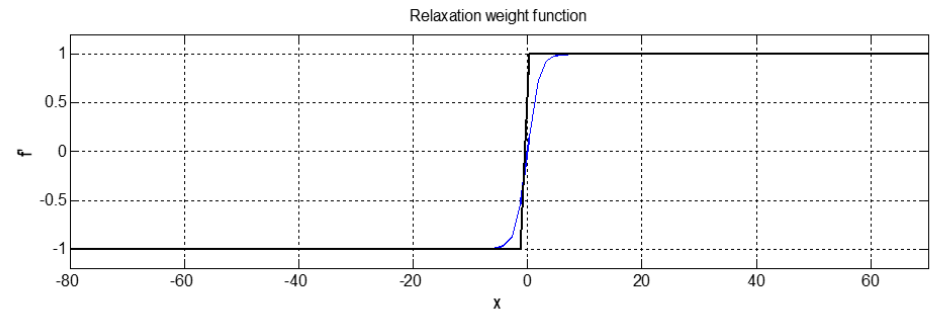
Figure 9. Comparison results of the weight functions before and after relaxation.